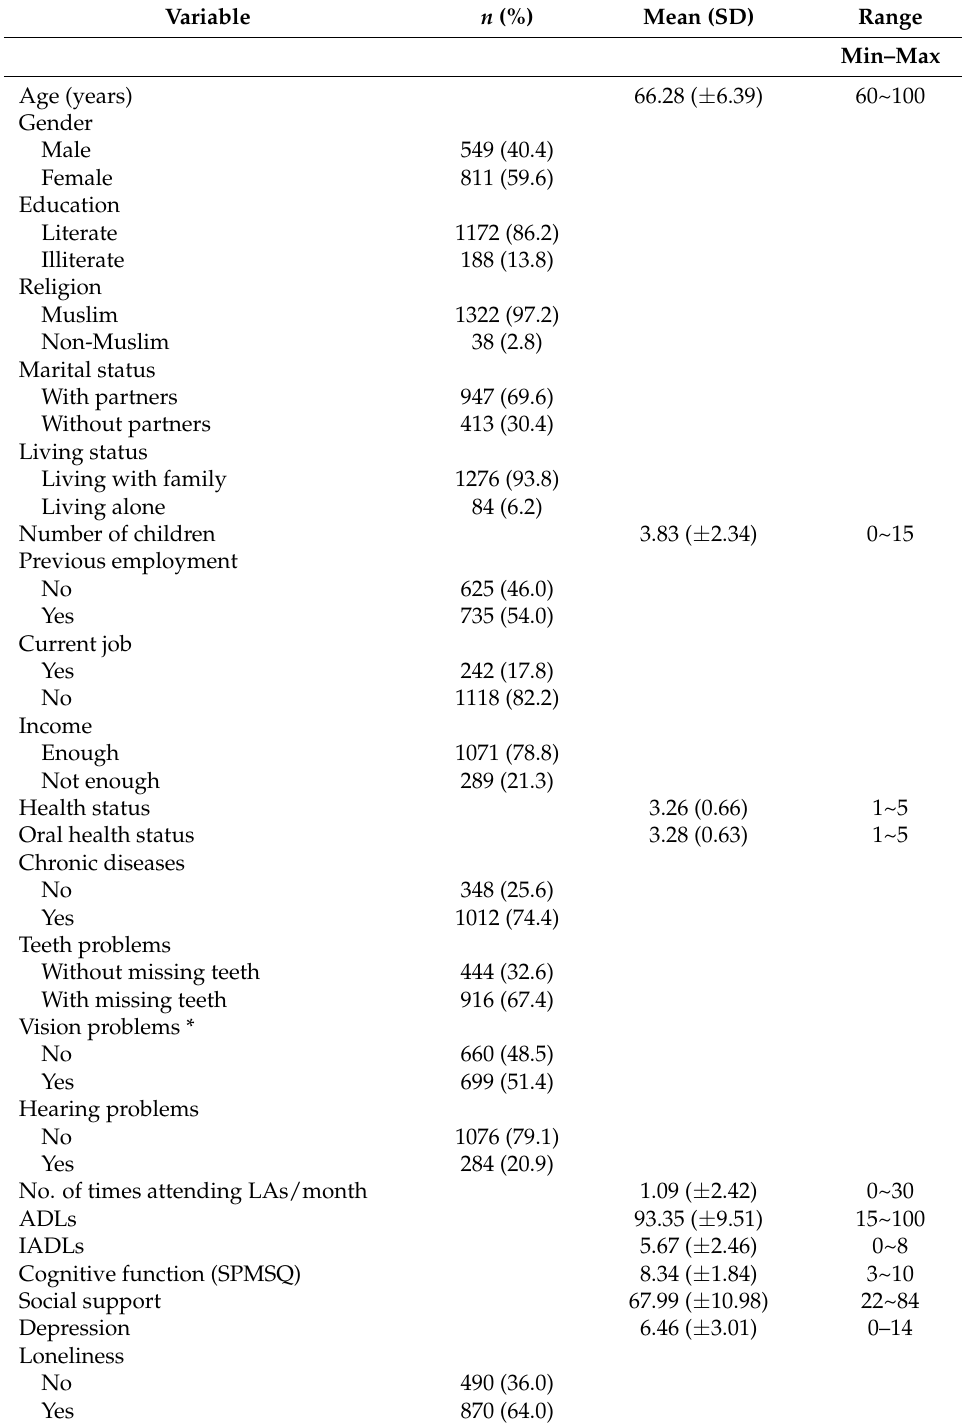
Table 1. Demographics and characteristics of participants ( N =